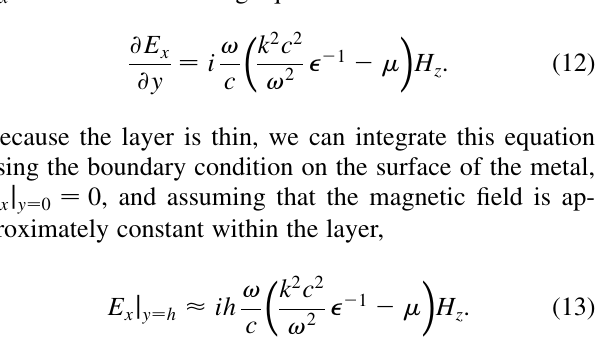
FIG. 4. Equipotential lines (blue) in a half cell of the